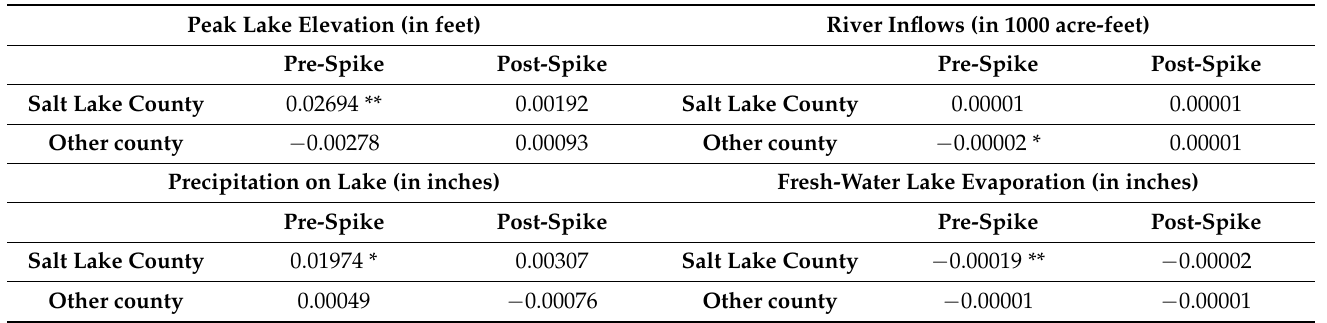
Table 3. Marginal effects of the relevant GSL measure on sex ratios at birth, by time and space. Peak Lake Elevation (in